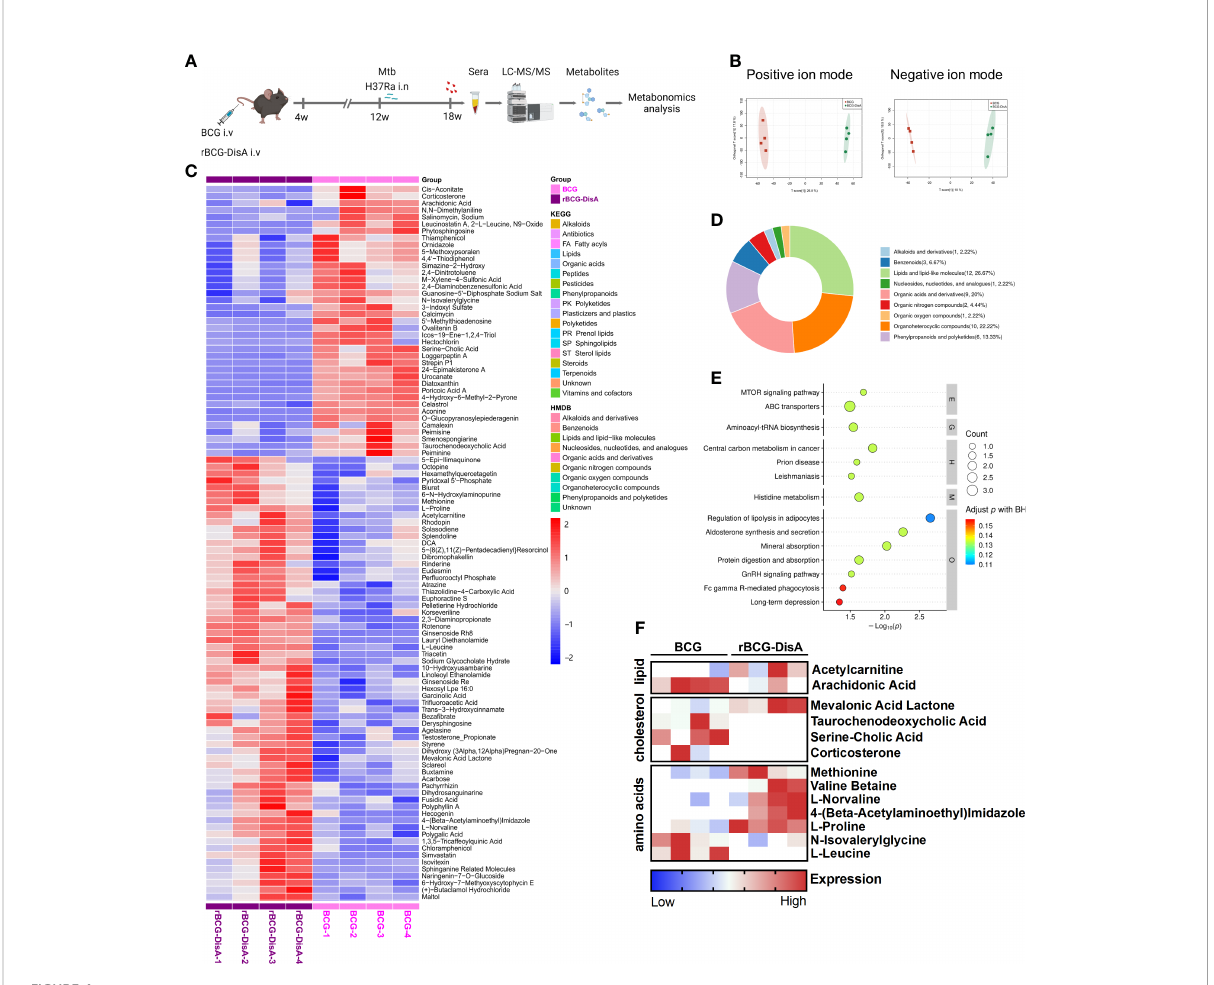
FIGURE 4 Metabonomics analysis of mice vaccinated with BCG or rBCG-DisA after M. tuberculosis infection. Mice were vaccinated by BCG and rBCG-DisA for 6 weeks. Then, mice were infected with M. tuberculosis by i.n route, normal mice (Naïve) and M. tuberculosis infected mice without immunization (UN) were used as control. At 8 weeks post infection, sera were harvested for metabonomics analysis ( n =4). (A) A scheme diagram of detection on sera of mice vaccine with BCG or rBCG-DisA (created with BioRender.com). (B) OPLS-DA score plots of positive and negative ion modes of BCG and rBCG- DisA groups ( n =4). (C) Heatmap of differential expressed metabolites of rBCG-DisA v.s BCG ( n =4). (D) Circle diagram of metabolites classi fi cation of rBCG-DisA v.s BCG ( n =4). (E) KEGG pathway enrichment of metabolites of rBCG-DisA v.s BCG ( n =4). (F) Heatmap of differential expressed metabolites regarding lipid, cholesterol and amino acids metabolism of rBCG-DisA v.s BCG ( n